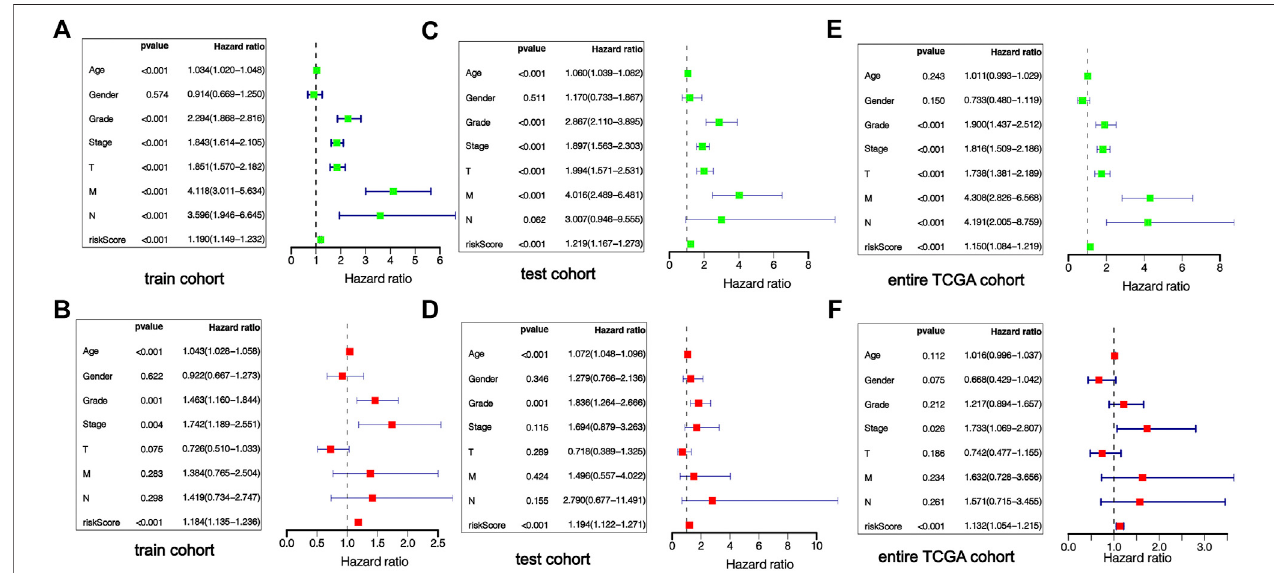
FIGURE 7 | Independent veri fi cation of prognostic risk score. The forest map results of univariate and multivariate regression analysis show that risk score is an independent prognostic factor of KIRC patients, training cohort (A,B) , testing cohort (C,D) , entire TCGA cohort (E,F) .